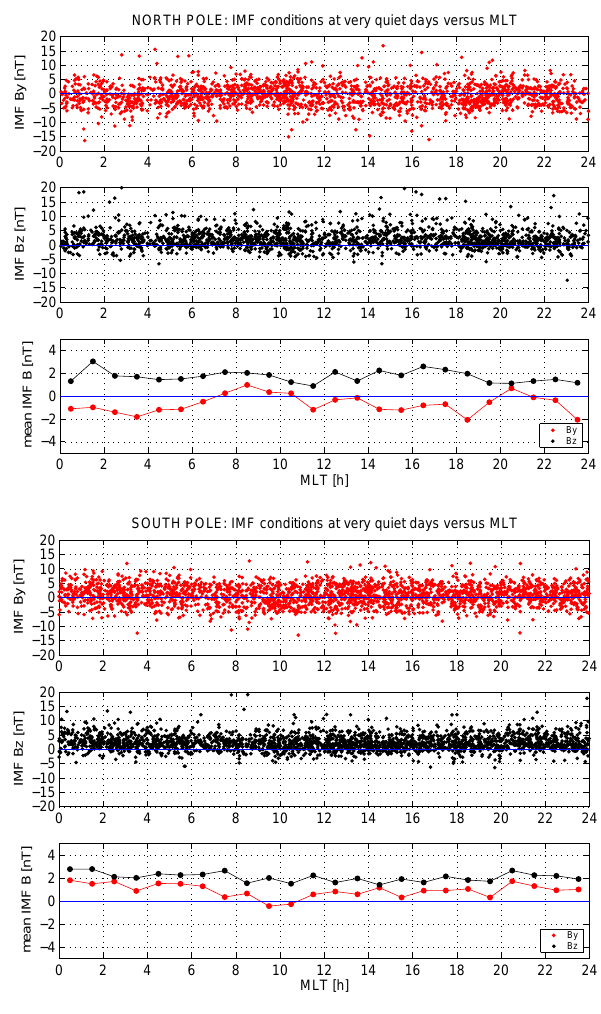
Fig. 7. IMF B y and B z distribution versus magnetic local time (MLT) during quiet polar events. The top frames contain the IMF components taken at the times of the transition between upward and downward FAC peaks for each orbit. The mean values shown in the bottom frames are averaged over